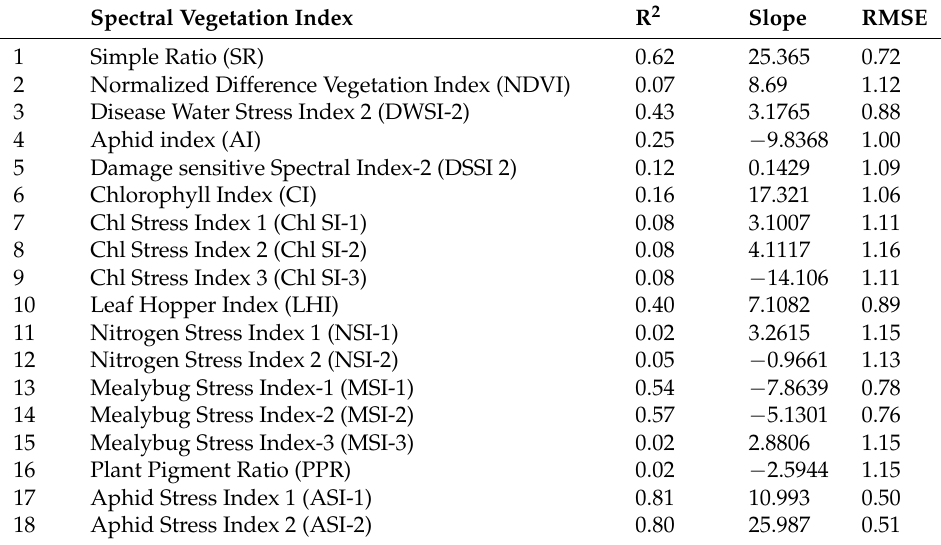
Table 6. Performance of different hyperspectral vegetation indices in linear regression model for assessing cotton aphid damage